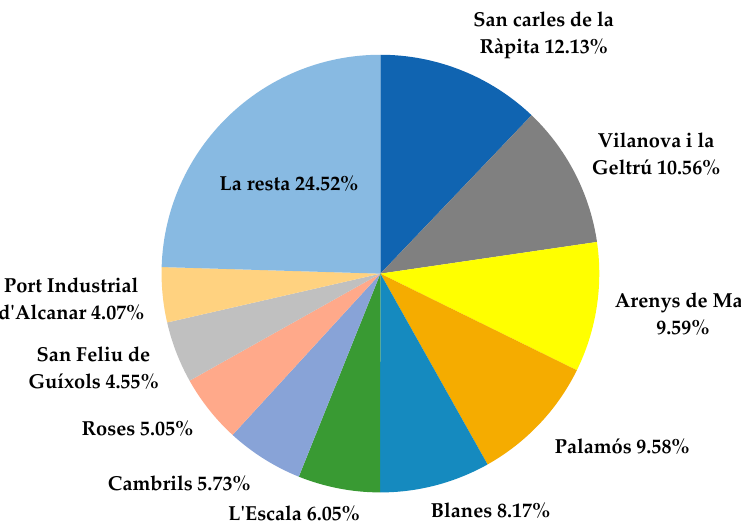
Figure 2. Economic activity of the ports of Catalonia, year 2020 [45].